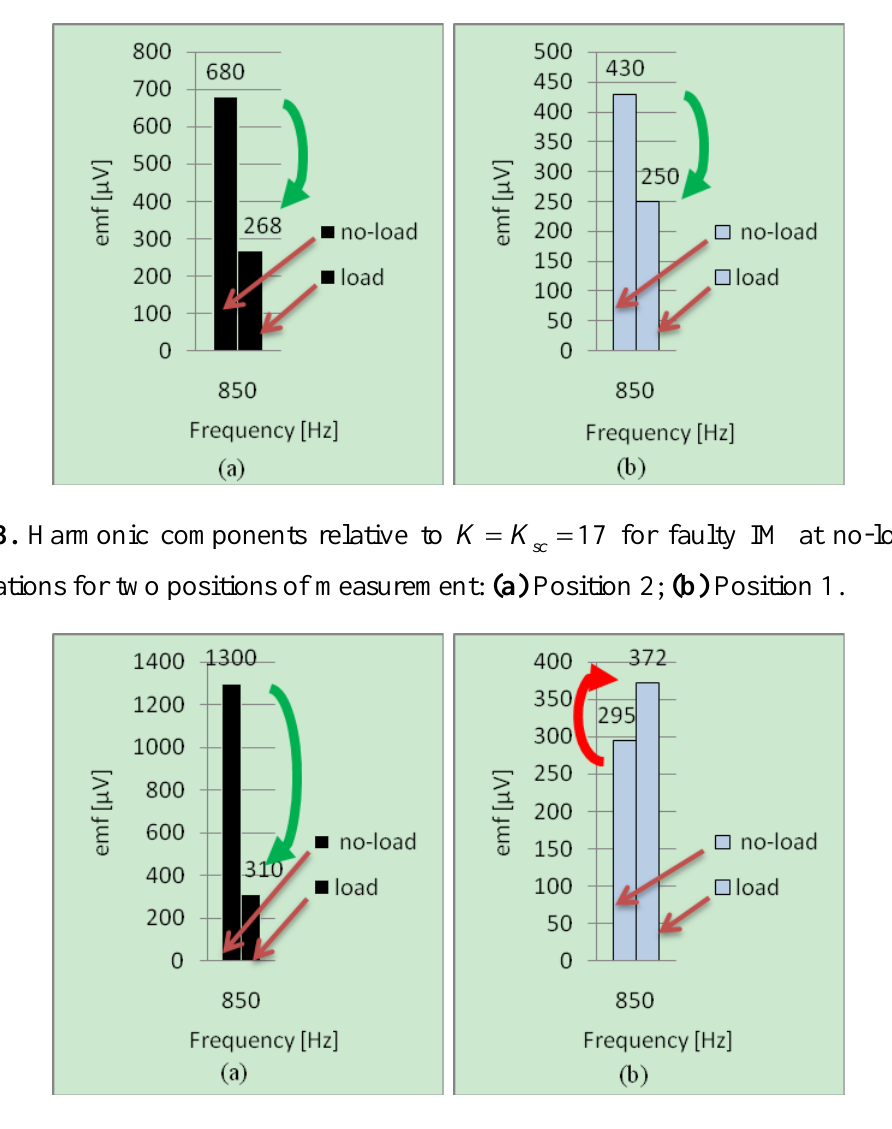
Figure 12. Harmonic components relative to 17 load operations for two positions of measurement: (a) Position 2; (b) Position 1.